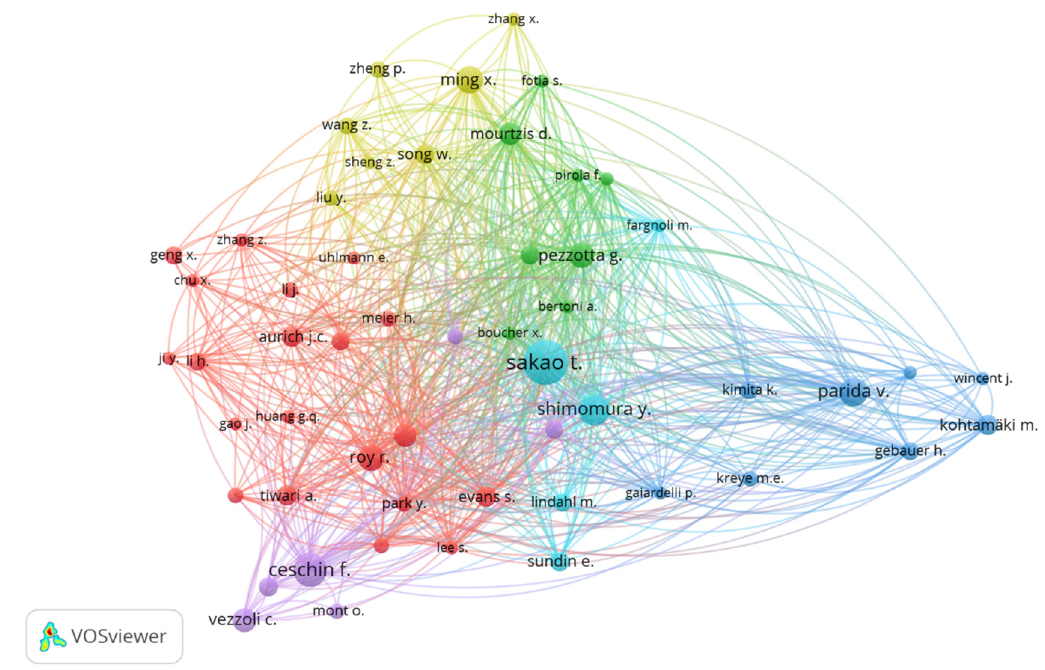
Figure 4. Network of cooperation based on co-authorship of the main authors.